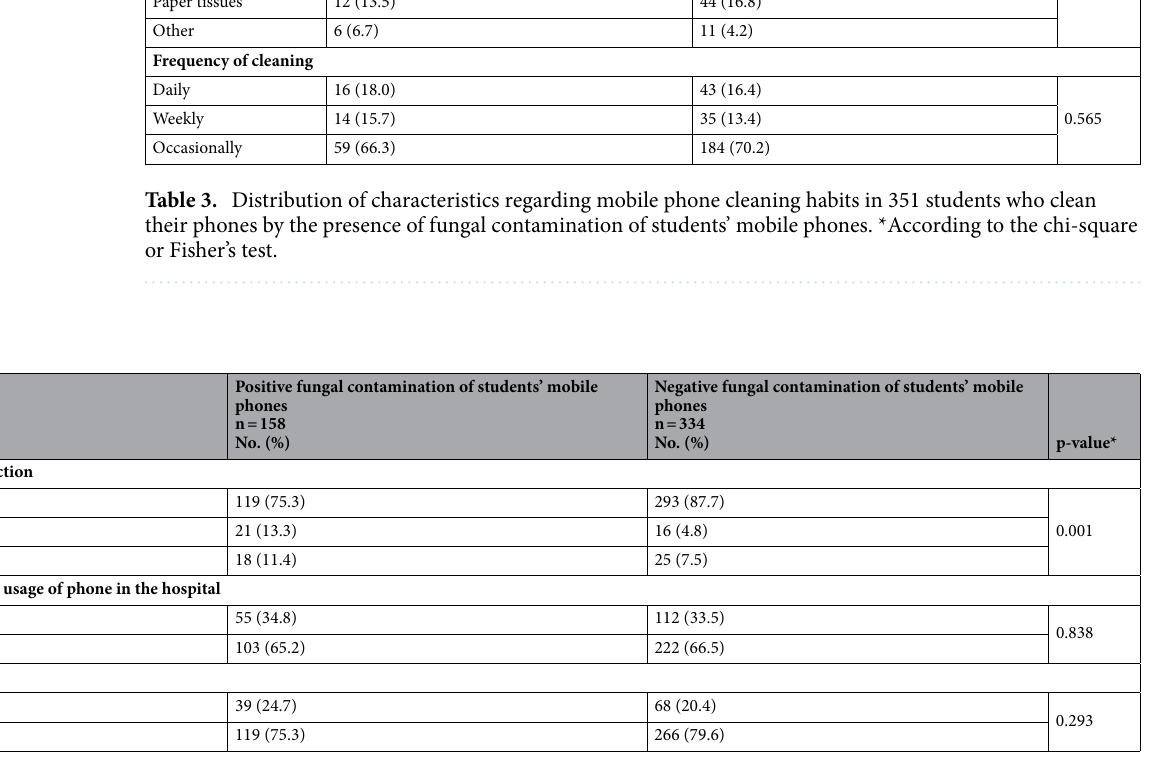
Table 4. Distribution of characteristics associated with awareness of mobile phones as a possible route of infection in 492 medical students by presence of fungal contamination on students’ mobile phones. SFI a superficial fungal infection. *According to the chi-square